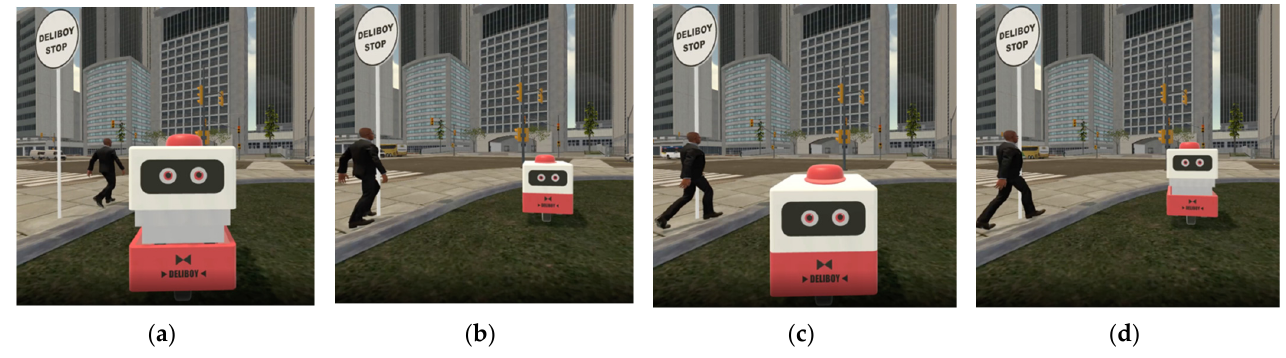
Figure 2. Design of videos within Scenario 1 ( a ) 1A: eye movement yes (1) and conversational distance near (1); ( b ) 1B: eye movement no (0) and conversational distance far (0); ( c ) 1C: eye movement no (0) and conversational distance near (1); ( d ) eye movement yes (1) and conversational distance near (1).